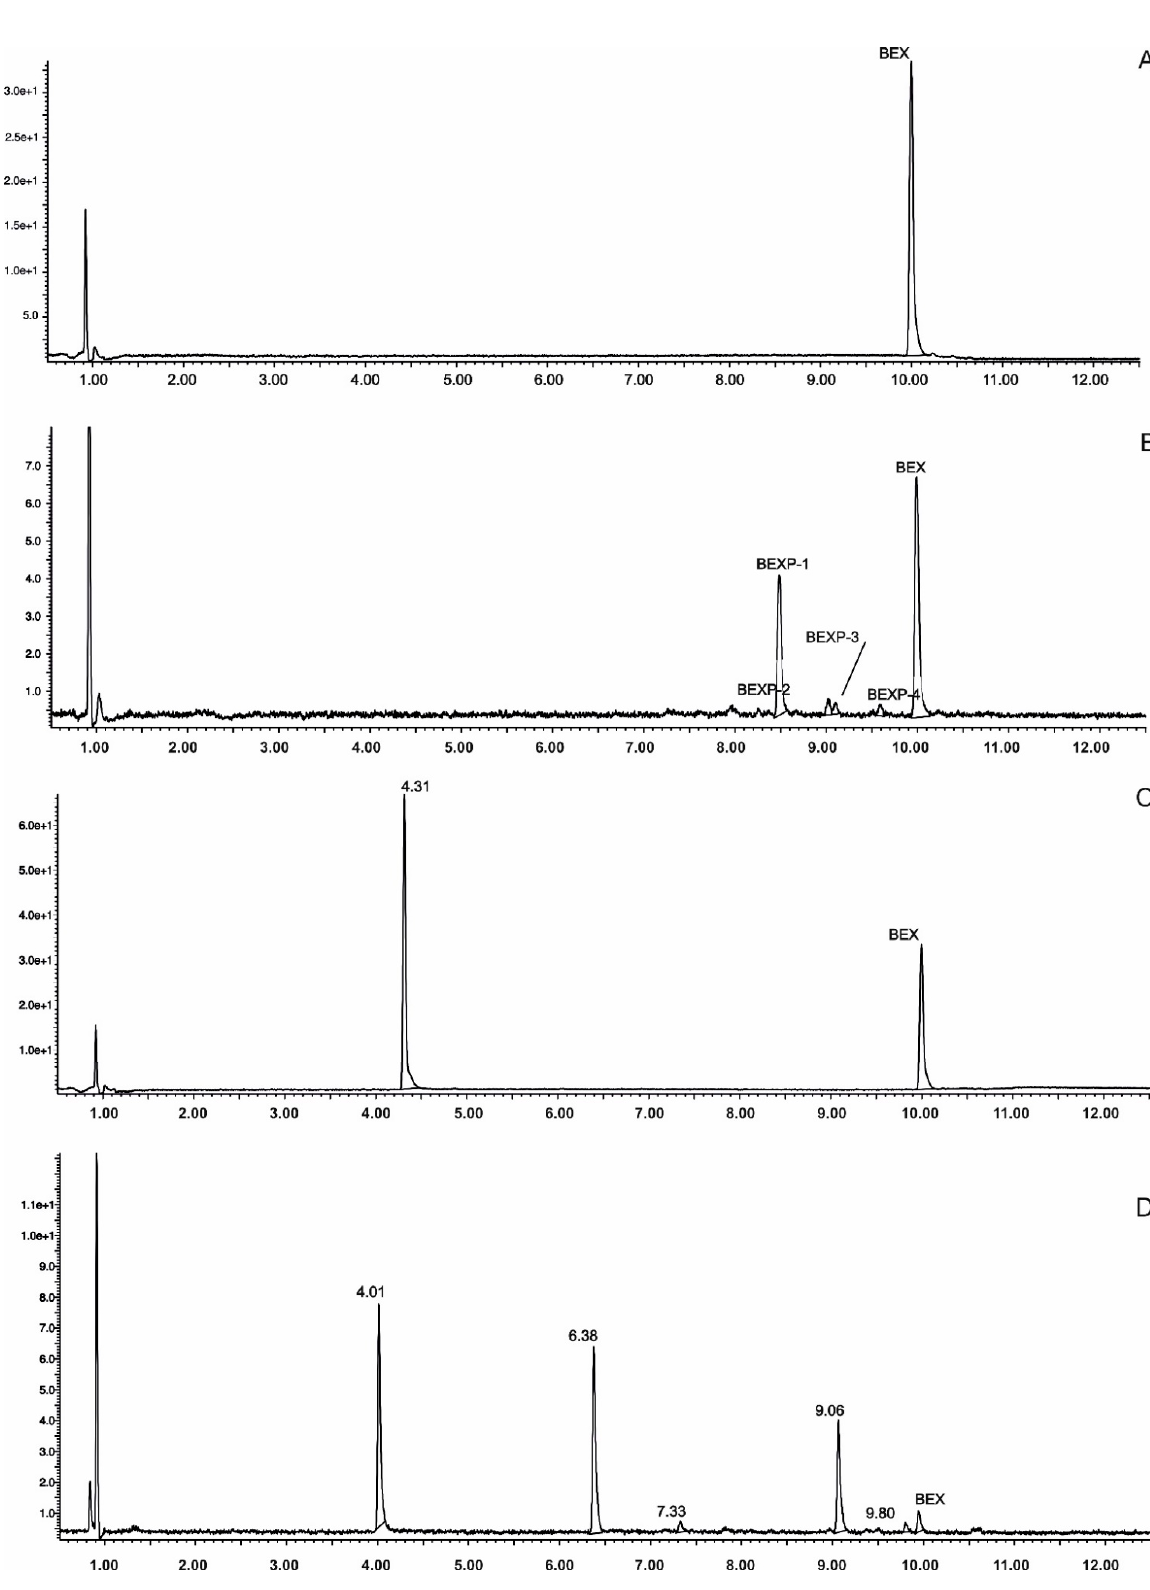
Figure 1. UPLC-MS/MS analysis of photostability of bexarotene: ( A ) pure standard substance; ( B ) photocatalytic degradation of bexarotene in ethanol solution after exposure to UV irradiation for 1 h in the presence of ZnO/TiO 2 ; ( C ) bexarotene with BP-2 in ethanol solution after exposure to UV irradiation for 1 h; ( D ) bexarotene gel 1 mg g − 1 with the addition of AVB after exposure to UV irradiation for 2 h.